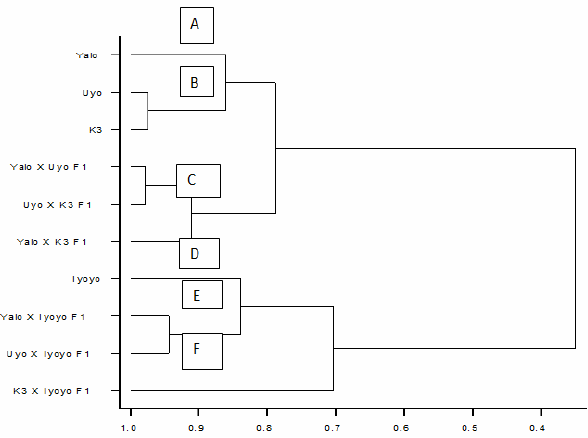
Fig. 2. Dendrogram showing the classification of 10 eggplant genotypes (genitors/F